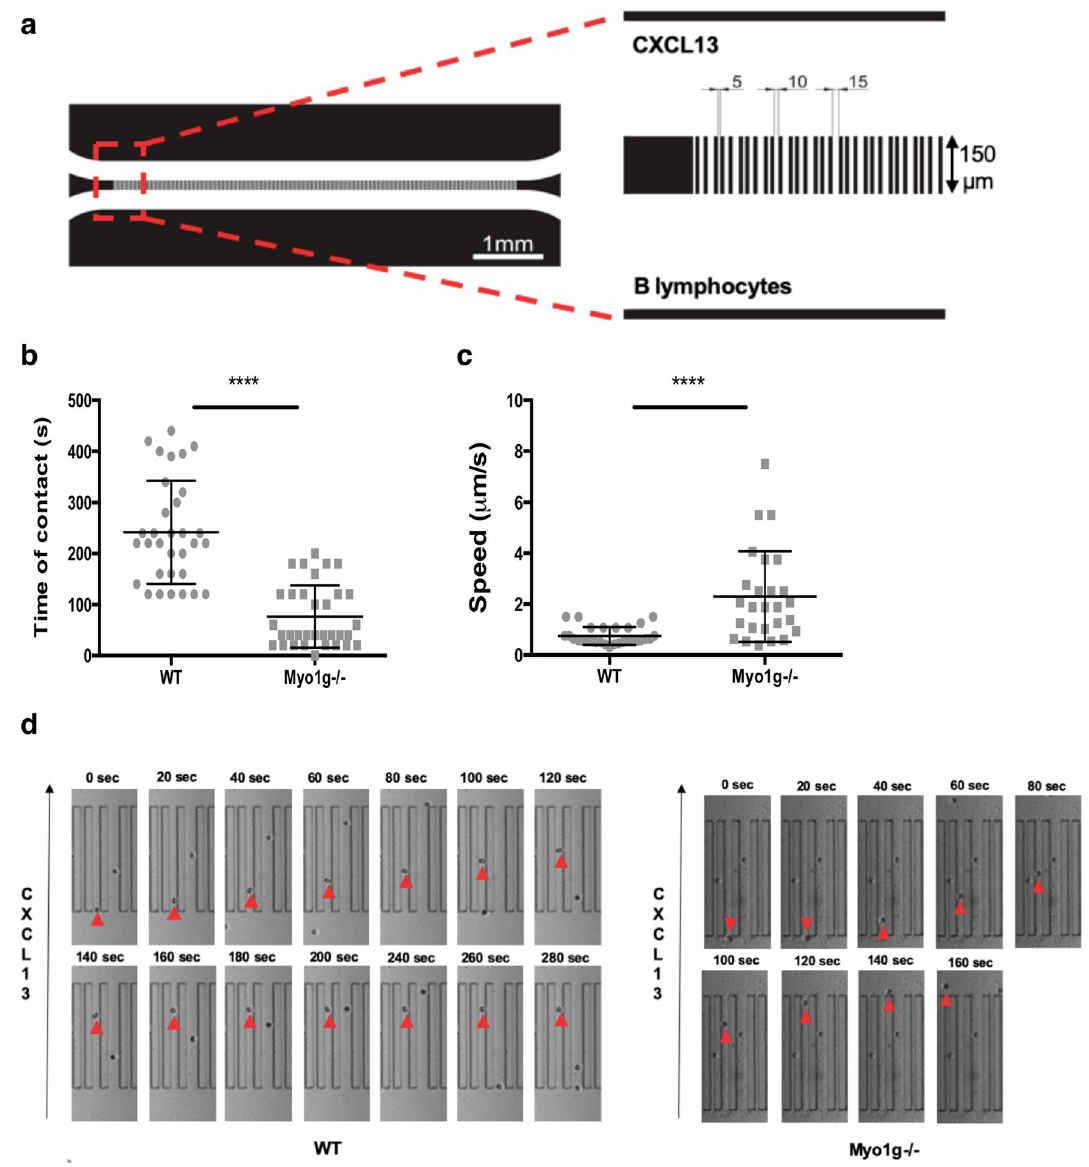
Figure 3. In the absence of Myo1g, activated B lymphocytes have altered motility in a confined 3D microchannel. ( a ) A general model of the microfluidic chamber. This device has 96 channels with gap widths of 5, 10, and 15 μm. Each channel is 150 μm long. Briefly, LPS + IL-4 activated WT or Myo1g −/− B lymphocytes are placed by gravity inside the chamber. Then, CXCL13 is applied on the opposite side. After that, migration is recorded by time-lapse microscopy. ( b ) Time of contact (s) of activated WT or Myo1g −/− B lymphocytes with the 10 μm microchannel wall. ( c ) speed (μm/s) of activated B lymphocytes moving through a 10 μm microchannel calculated while the cells were moving within the microchannel. ( d ) Representative still images showing displacement of the cells over time; (red arrows). Data are presented as mean ± s.d. ****P <